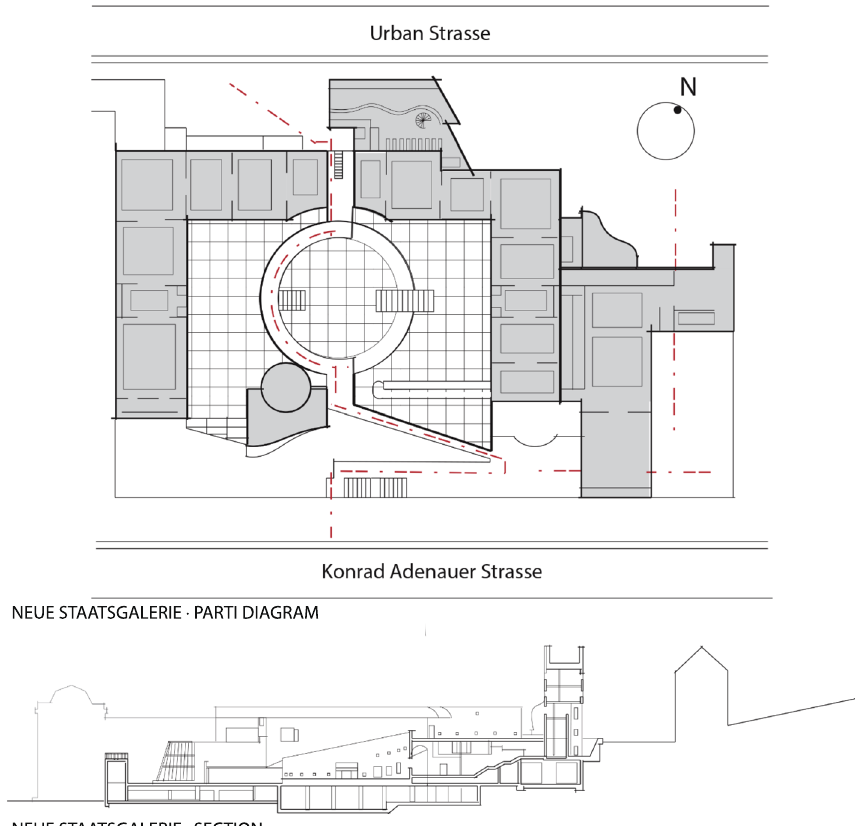
Fig. 6 Neue Staatsgalerie, Stuttgart, Germany, 1984. Above: Site plan. Below: building section (Source: the